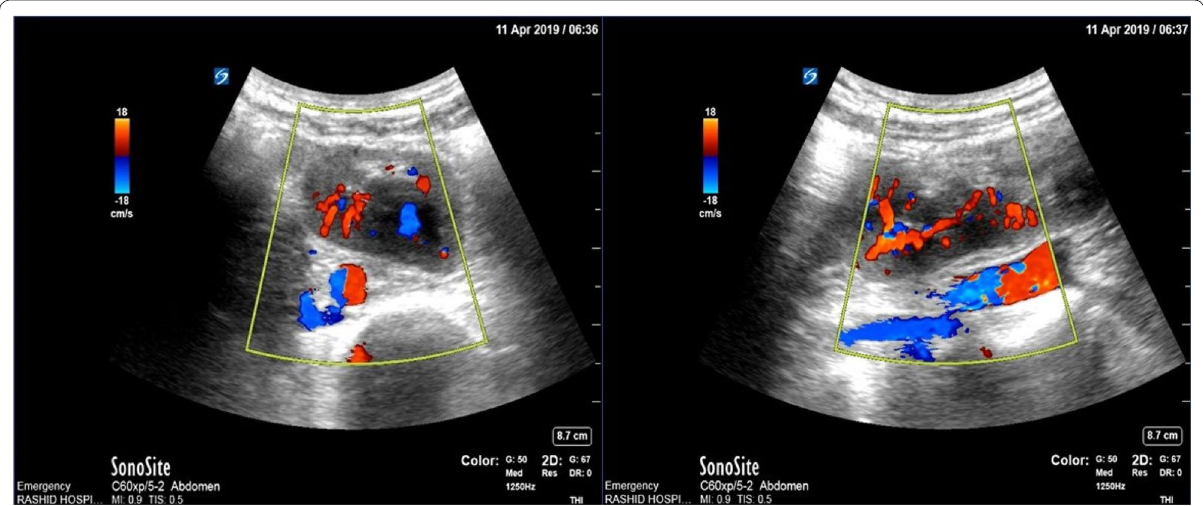
Fig. 4 The color Doppler of great value by demonstrating a normal vascular architecture that is compatible with renal